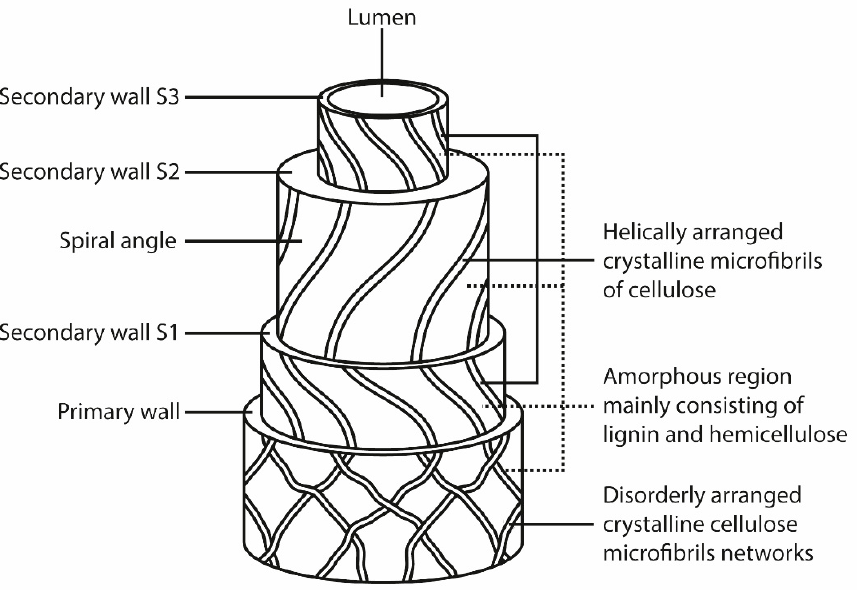
Figure 1. Shows structural constituents of a natural plant fiber. Reprinted with the permission from the publisher